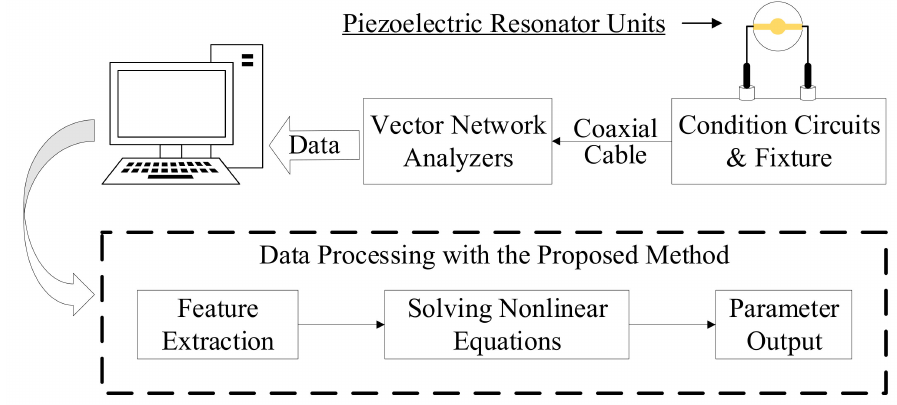
Figure 3. Schematic diagram of the